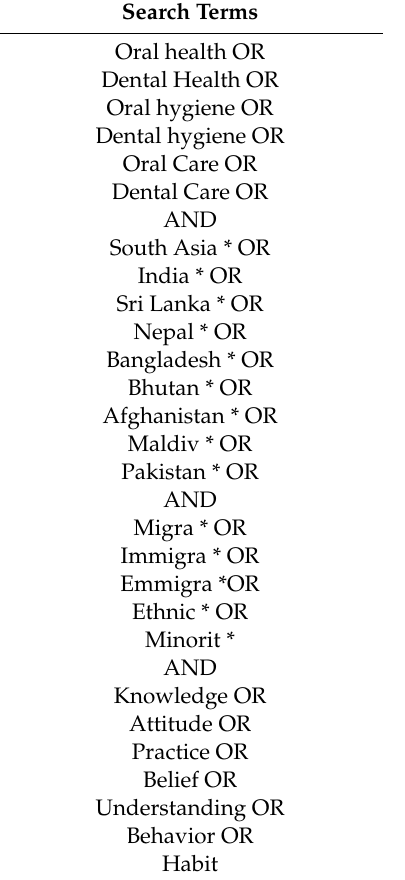
Table 1. Search terms used for the search